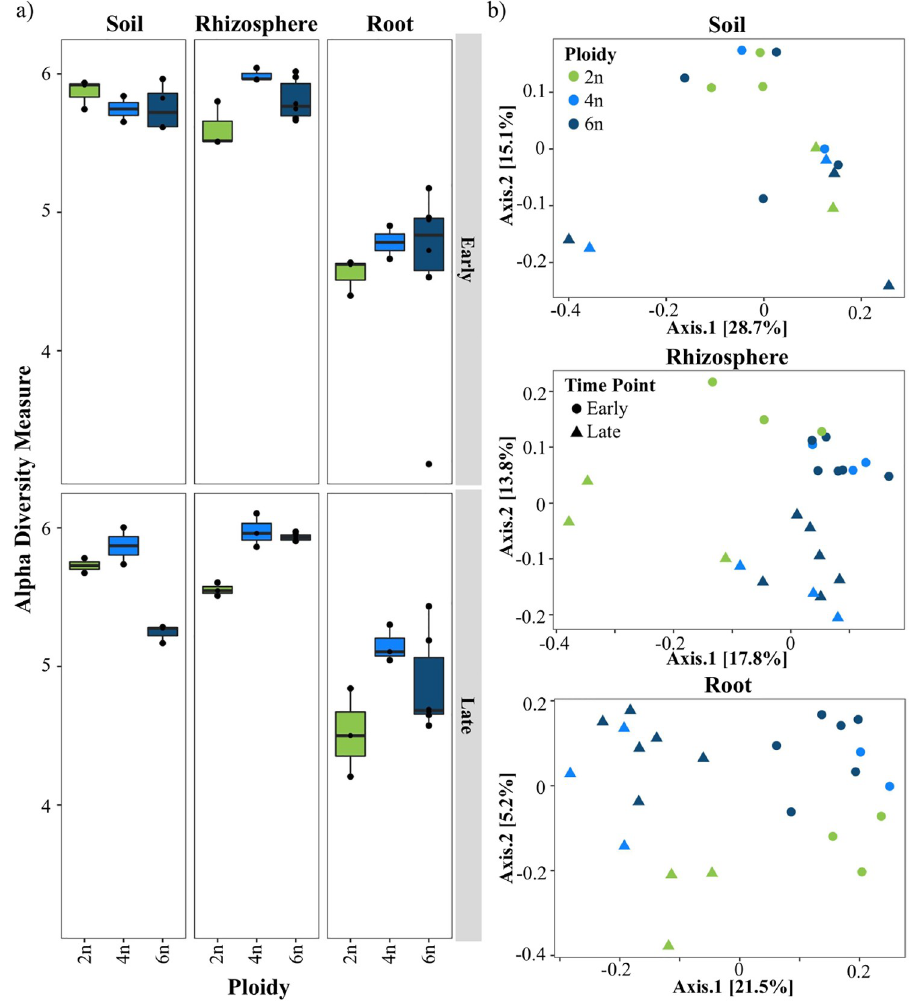
Fig 2. Polyploidy corresponds to greater alpha diversity, as compared to diploids. Analyses of the 2015 field study data presented as box plots of Shannon’s Diversity (a) and principal coordinates analysis plots based on Bray-Curtis dissimilarity (b), faceted by sample type (soil, rhizosphere, and root) and time point (early and late; indicated by circles and triangles, respectively, in b). Ploidy level represented by light green (2n), blue (4n), and dark blue (6n).